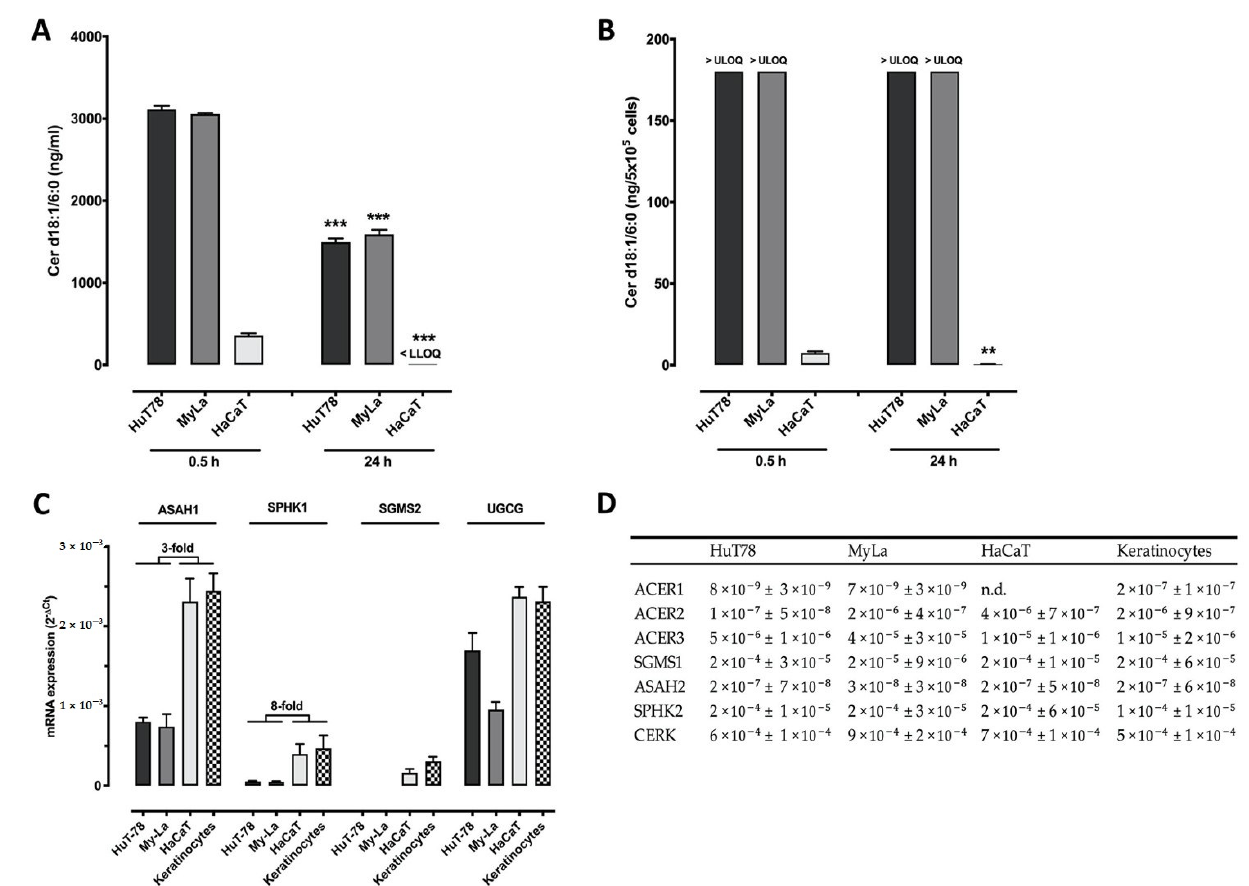
Figure 3. HaCaT keratinocytes catabolize C6 ceramide faster compared to cutaneous T cell lymphoma cell lines. ( A , B ): HaCaT cells were treated with 25 µM C6 ceramide (C6Cer), T cells with 12.5 µM C6Cer for 0.5 h and 24 h. The concentration of Cer d18:1/6:0 was measured by LC-MS/MS in the supernatant ( A ) and cell pellet ( B ). ( C , D ): Basal mRNA expression of acid ceramidase (ASAH) 1–2, sphingosine kinase (SPHK) 1–2, sphingomyelin synthase (SGMS) 1–2, Ceramide glucosyltransferase (UGCG), alkaline ceramidase (ACER) 1–3 and ceramide kinase (CERK) determined by TaqMan ® and shown as ∆ Ct values. Data are shown as means ± SEM ( n = 3–4), ** p < 0.01, *** p < 0.0001. Abbreviations: Not detectable (n.d.); lower limit of quantification (LLOQ): 6 ng/mL; upper limit of quantification (ULOQ): 180 ng/pellet. *** in ( A ), ** in ( B ): significantly different compared to 0.5 h.